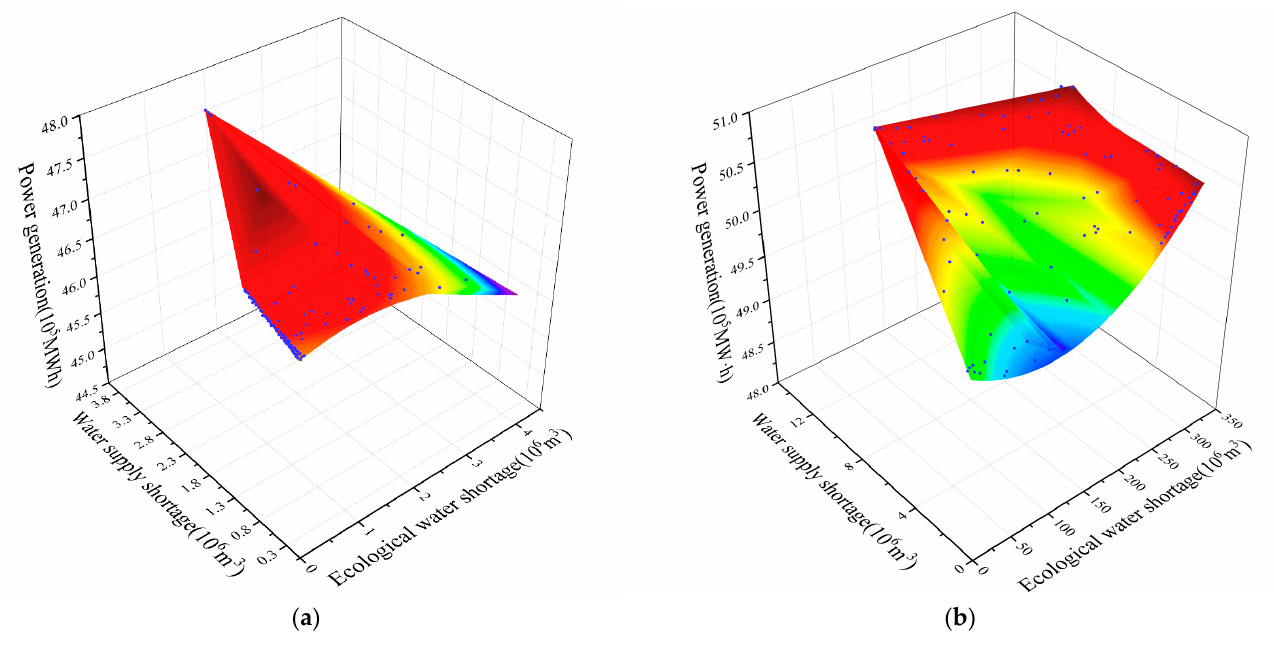
Table 5. The control range of discharge established by the Yellow River Conservancy Commission (YRCC) in the ice flood season.